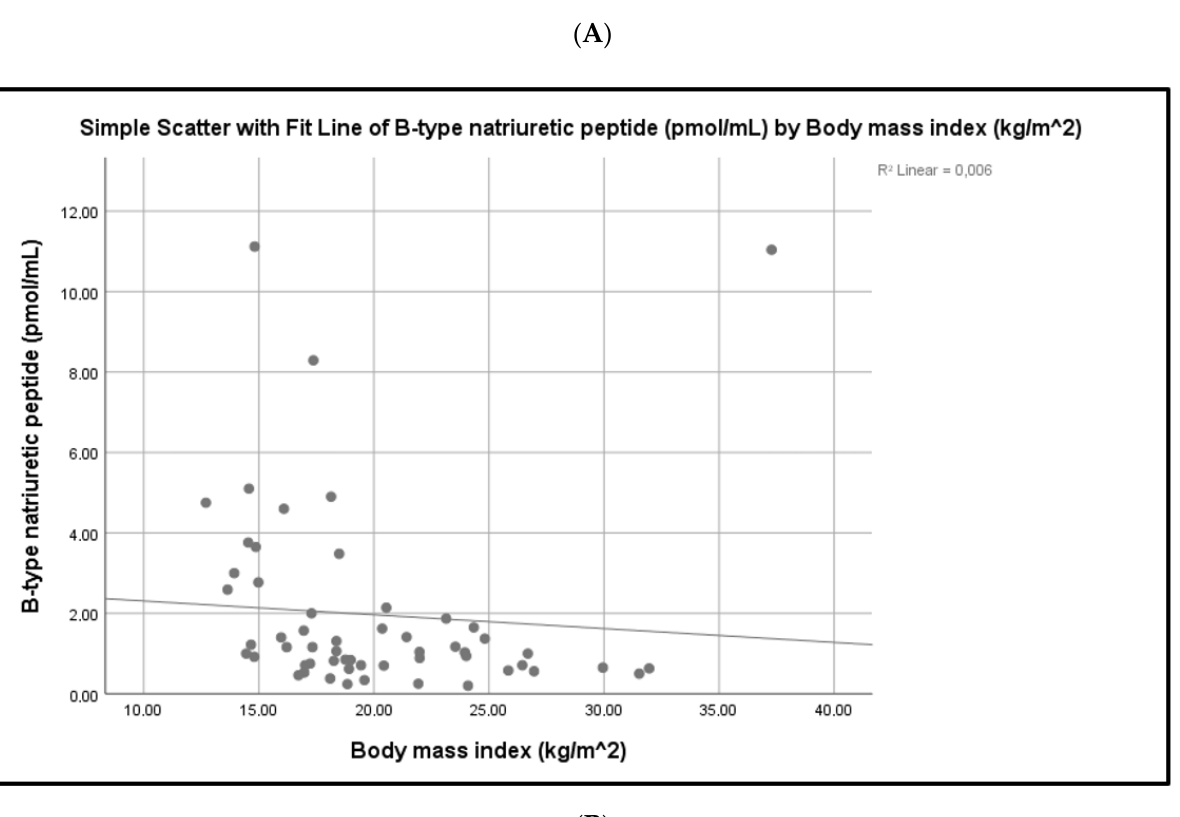
Figure 1. ( A , B ). Correlation of plasma BNP levels with age and BMI. In contrary, gender, pubertal stage, duration of CKD and medication use (predniso- lone, other immunosuppressive and antihypertensive drugs) were not associated with median plasma BNP levels ( p > 0.05). A significant inverse correlation was found between plasma BNP levels and eGFR (Figure 2, p < 0.001) and a positive one with CKD stage, with the higher levels found in CKD stage 5 ( p = 0.005).